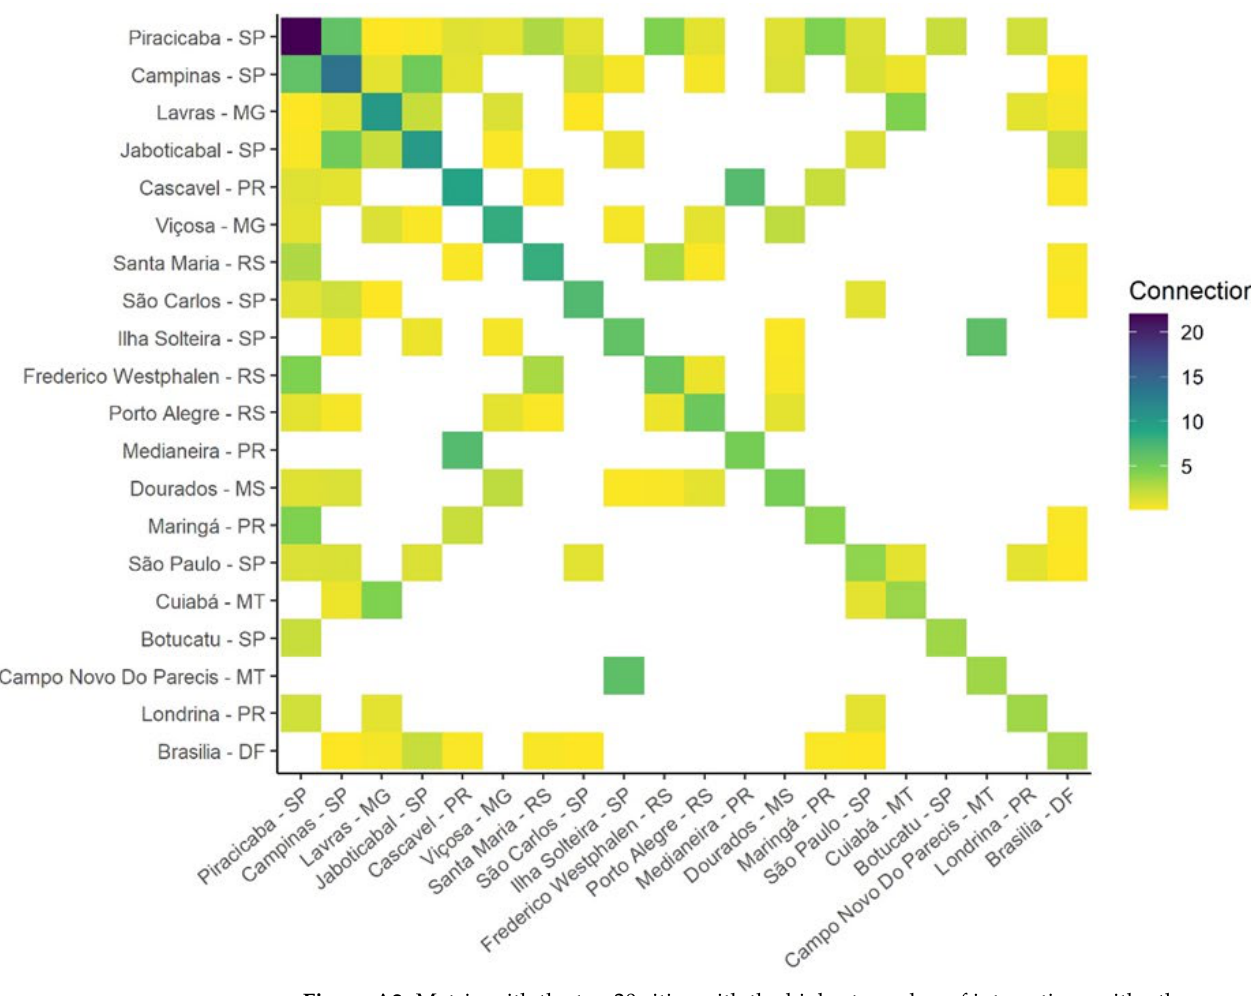
Figure A2. Matrix with the top 20 cities with the highest number of interactions with other research groups that resulted in scientific papers; on the main diagonal, the sum of the total weight of connections for each city is shown, and the other cells show the weight of each pair of cities.